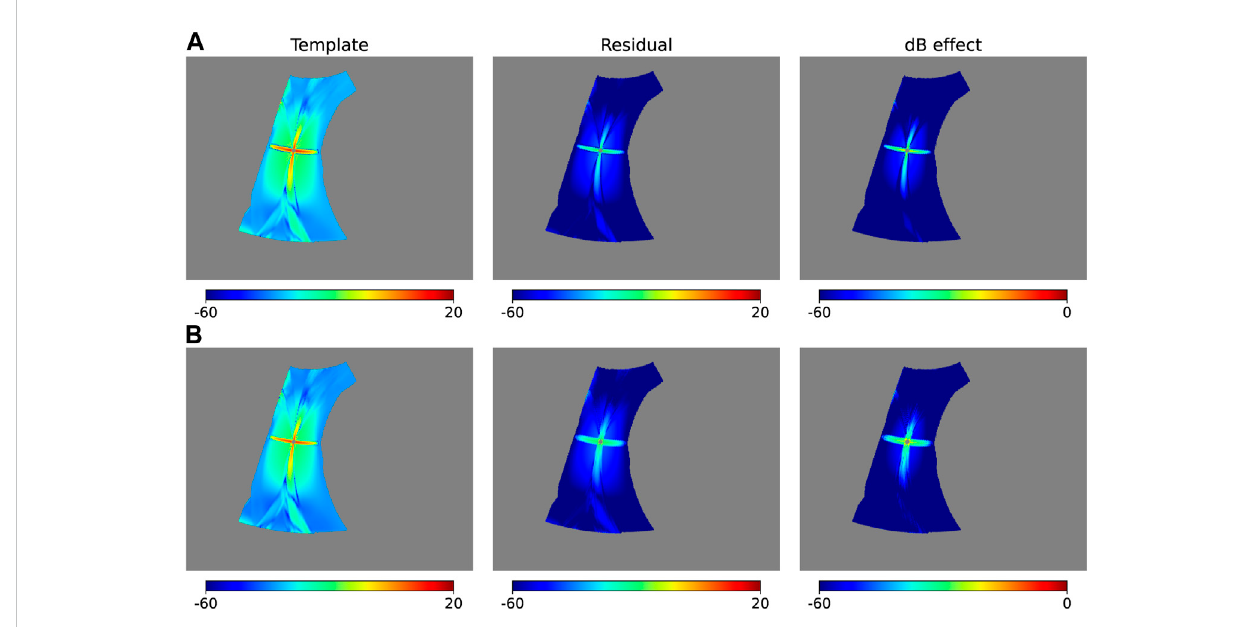
FIGURE 1 Comparisonofresultsinunitsofdecibels(dB)for r =0.023,obtainedusingtheidealtemplate (A) andtherealistictemplate (B) ,forthecaseofasingle point source with a given polarization direction, where thepolarization valuesof thetemplates (left), theresiduals (middle) from Eq.14 and the dBeffects (right) as de fi ned in Eq. 16 are shown,